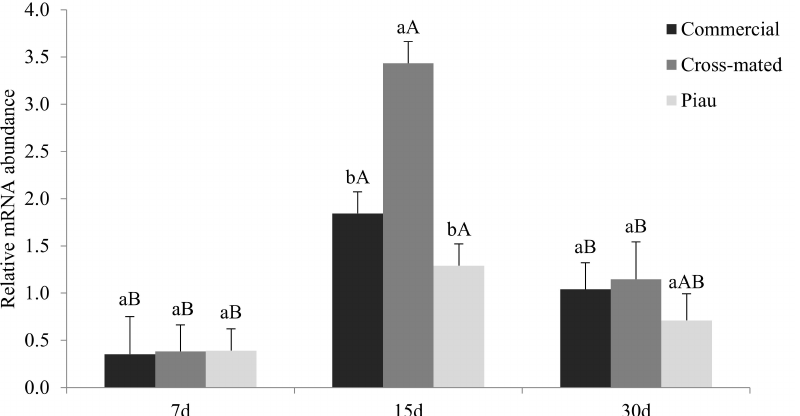
Figure 4. RTA of the ANG1 gene according to gestational age in commercial gilts and Piau breed gilts mated with commercial males (cross-mated) and Piau breed males (Piau). Within the days of pregnancy, different lowercase letters indicate differences among breeds ( p < 0.05). Within groups, different uppercase letters indicate differences among days of pregnancy ( p < 0.05). Bars,